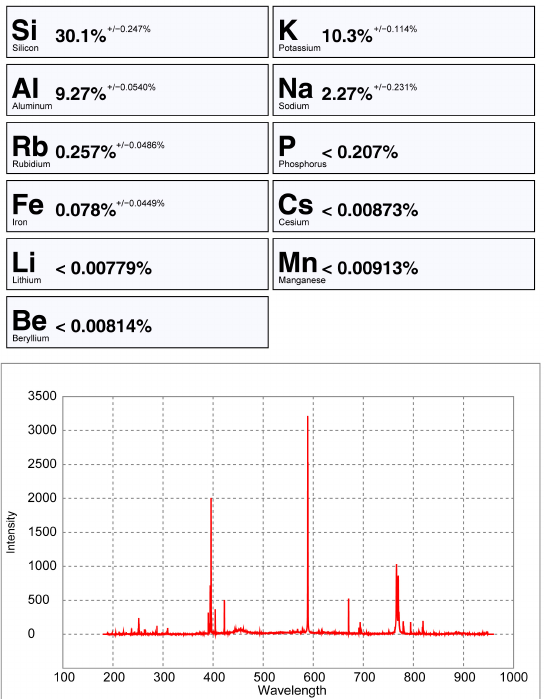
Minerals 2023 , 12 , x